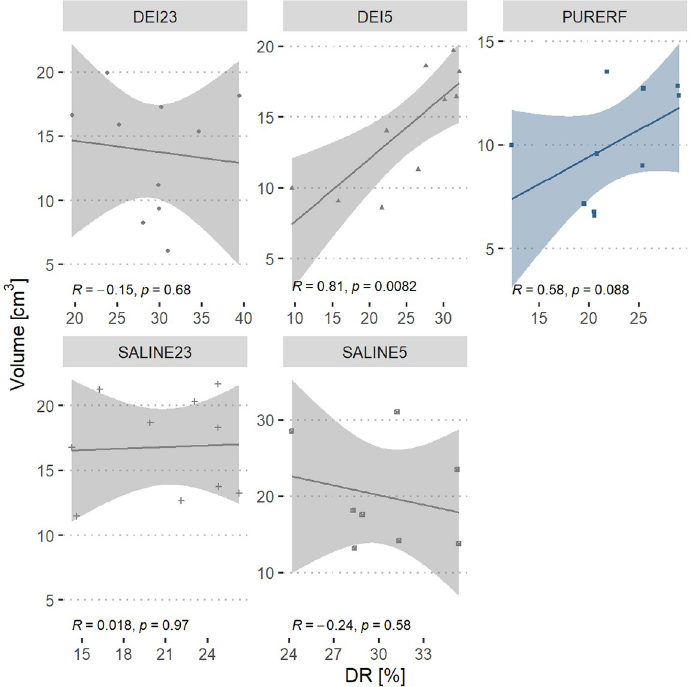
Fig 8. Correlation between DR performance index and volume. The graph presents the correlation of the volume in groups to the DR index. The direct correlation is statistically significant in the DEI5 group.